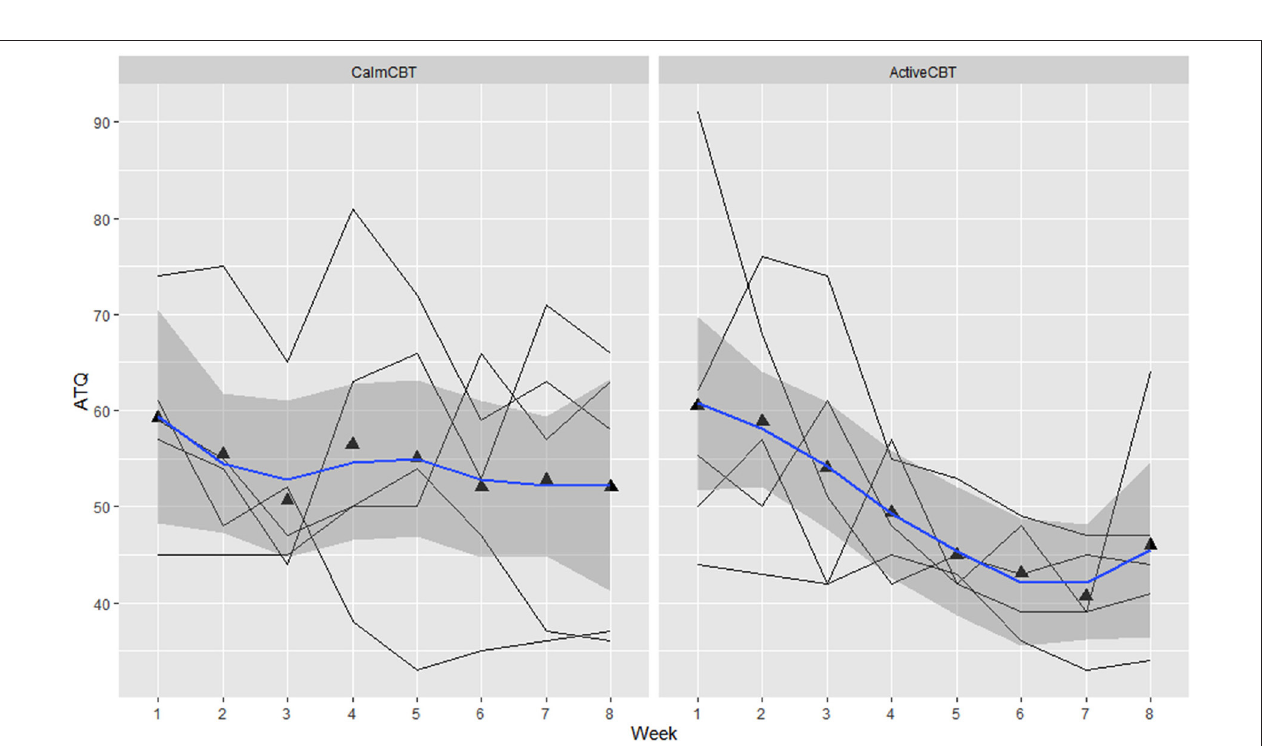
FIGURE 6 | Changes in automatic thoughts questionnaire (ATQ) by group over time. Data are total scores of the ATQ administered at the beginning of each CBT session visit (i.e., before the Active/Calm condition). Lower total scores indicate lower frequency of negative thoughts.